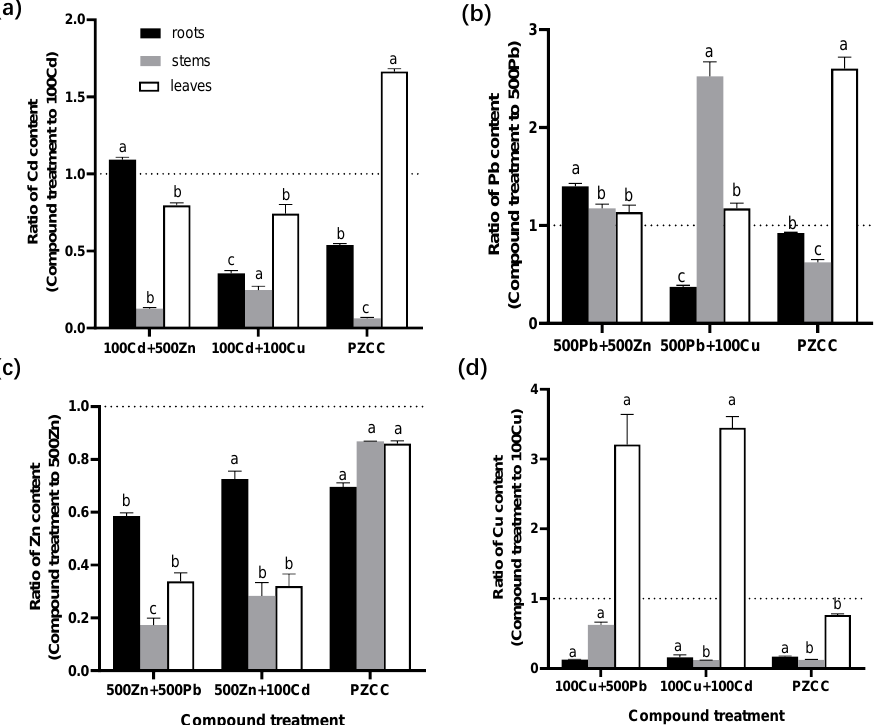
Figure 6. Content ratios of Cd ( a ), Pb ( b ), Zn ( c ), and Cu ( d ) in roots, stems, and leaves of M. cordata under compound treatments of 100Cd, 500Pb, 100Cu, and 500Zn. PZCC means the mixed treatment of 500Pb, 500Zn, 100Cd, and 100Cu. Values are means ± SEs ( n = 3) of three different experiments. If the mean is greater than 1, it means upregulation by compound treatment; otherwise, it means downregulation. Means denoted by different letters refer to the significant differences ( p < 0.05, Duncan’s